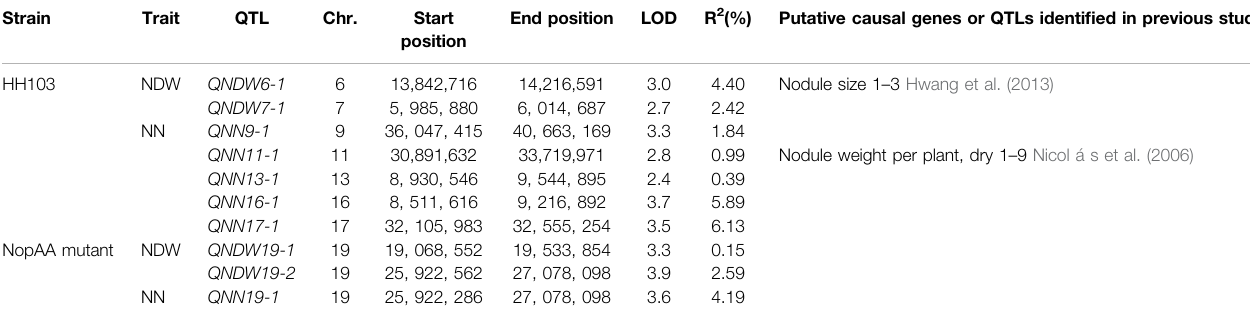
TABLE 2 | Main QTLs identi fi ed in the